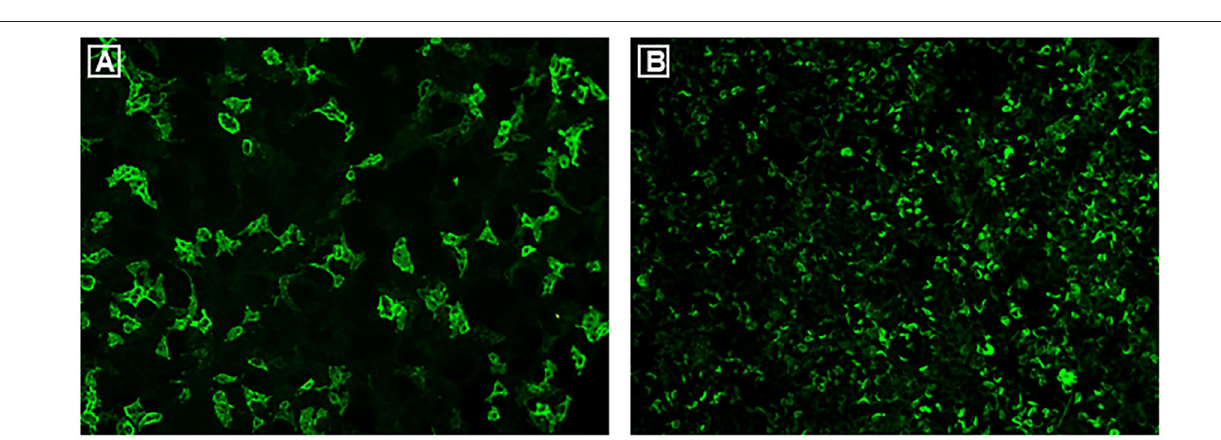
FIGURE 3 | Commercial CBAs were used to examine autoantibodies in serum in 2020. Both MOG-IgG and GFAP α -IgG were positive with titers of 1:320 (A) and 1:100 (B) ,